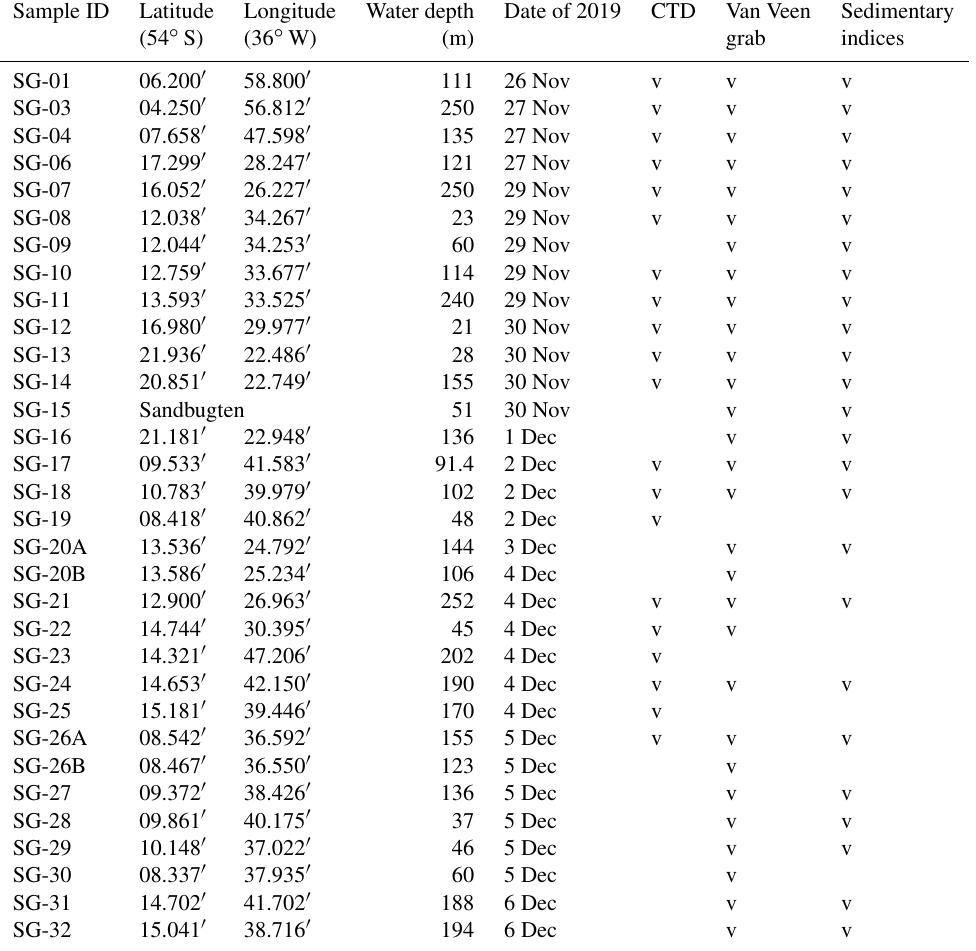
Table 1. List of stations investigated for this study. Sedimentary indices include grain size, total carbon, total organic carbon, total sulfur, and δ 13 C of bulk organic matter (indicated in Table S1 in the Supplement). Note that CTD is for conductivity, temperature, and